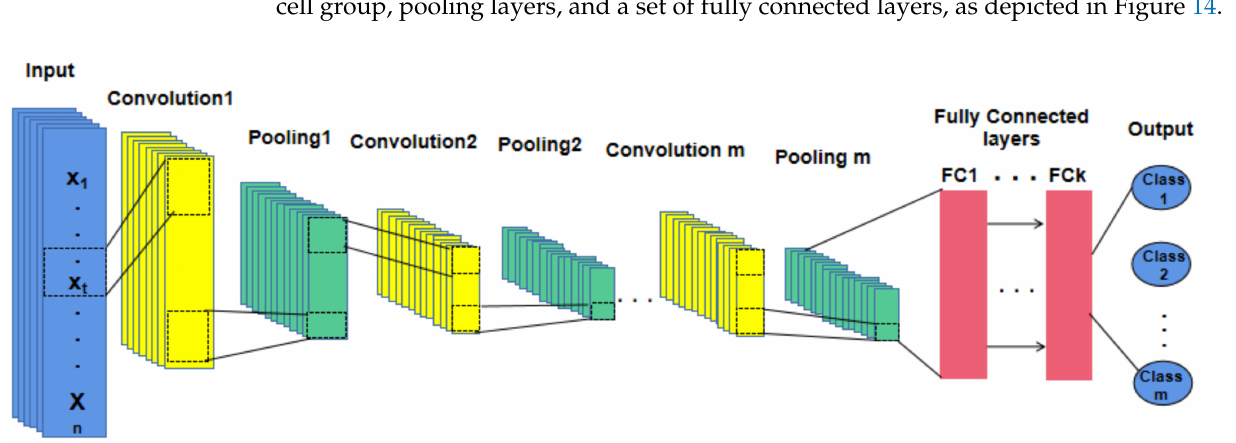
Figure 14. The architecture of traditional Convolutional Neural